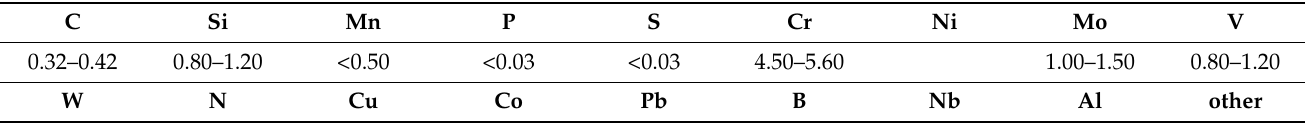
Table 2. Chemical composition (%) of ADC12.